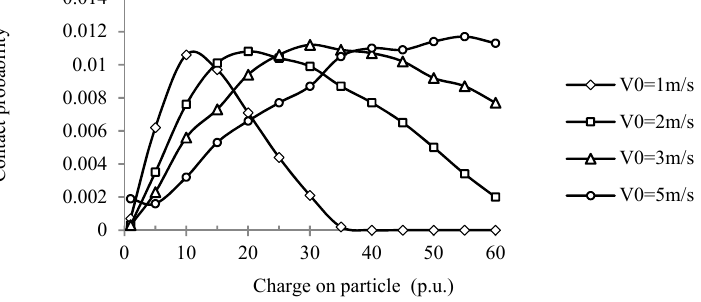
Figure 9. The relationship of electric charge on particles and particles contact probability with different airflow velocity V 0 .